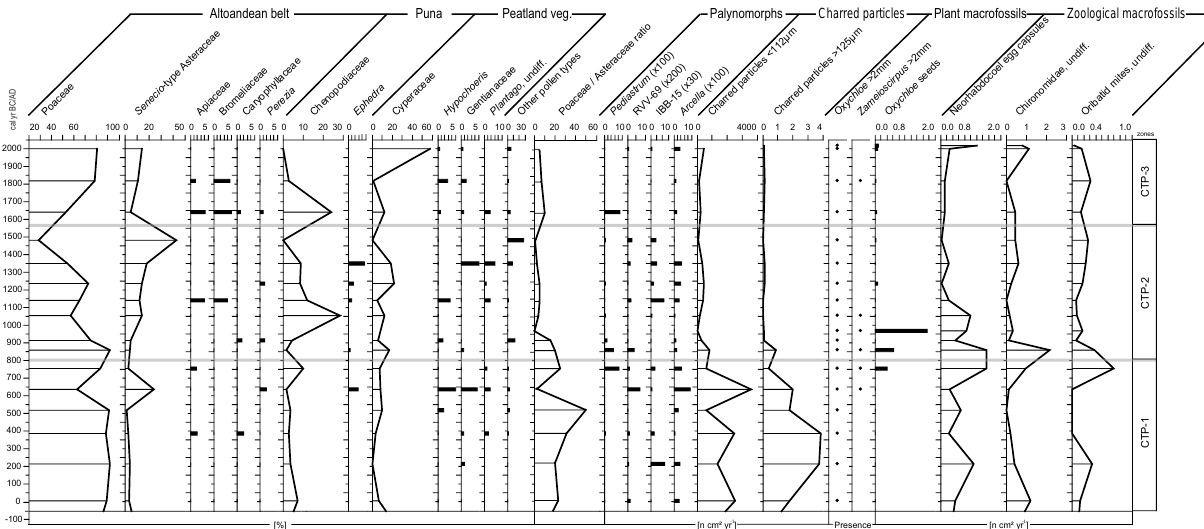
Figure 4. Pollen, palynomorphs, charred particles and macrofossils diagram for core Tuz 694 of Cerro Tuzgle peatland. Peatland vegetation was excluded from the pollen